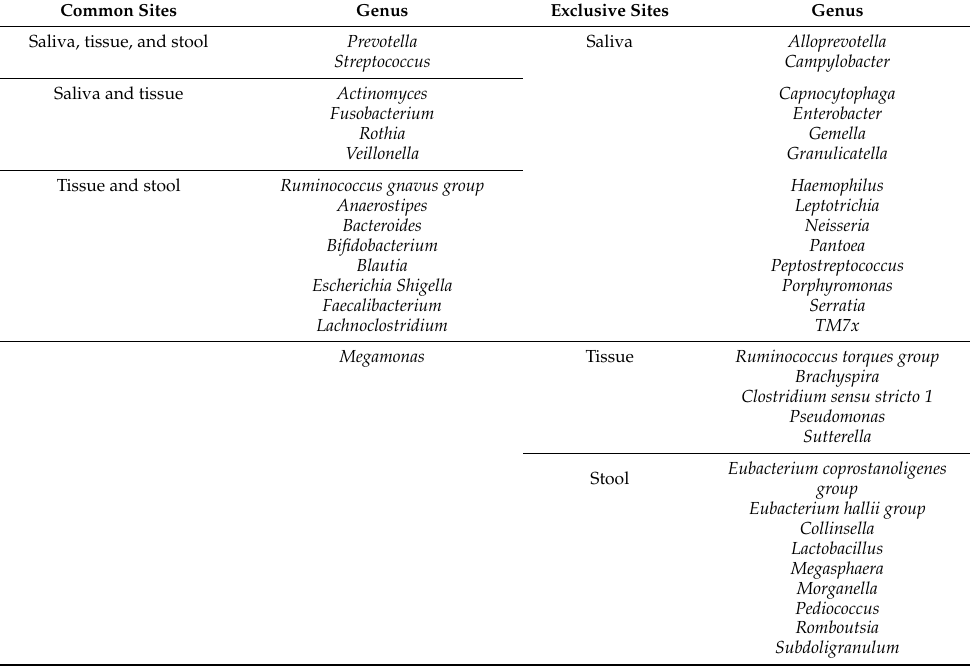
Table 3. Common and exclusive genera among saliva, tissue, and stool samples.